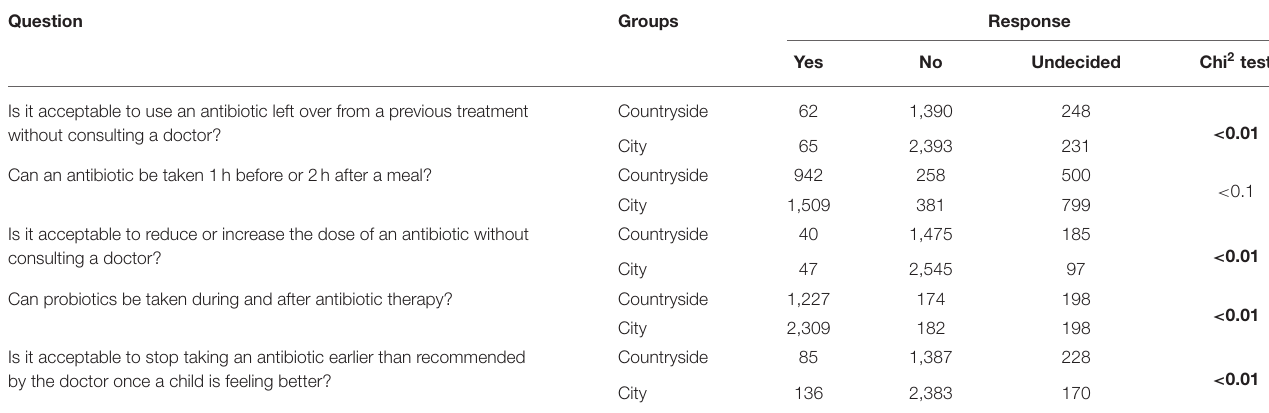
TABLE 4 | Responses to the knowledge